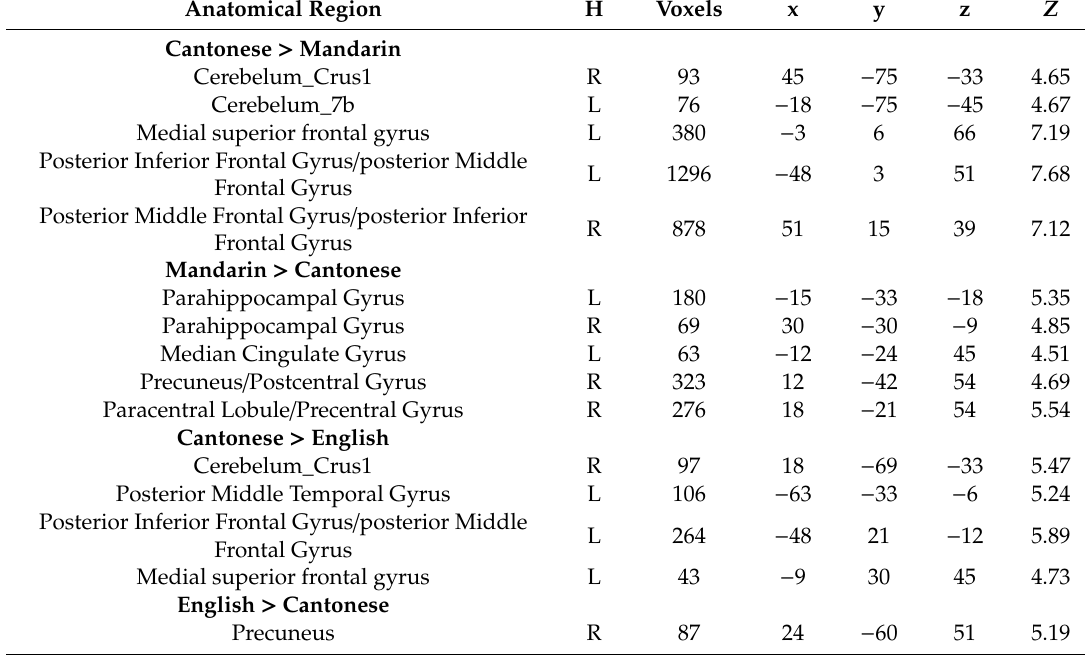
Table 4. Brain activity for the contrast of rhyming minus control for the group comparisons in visual